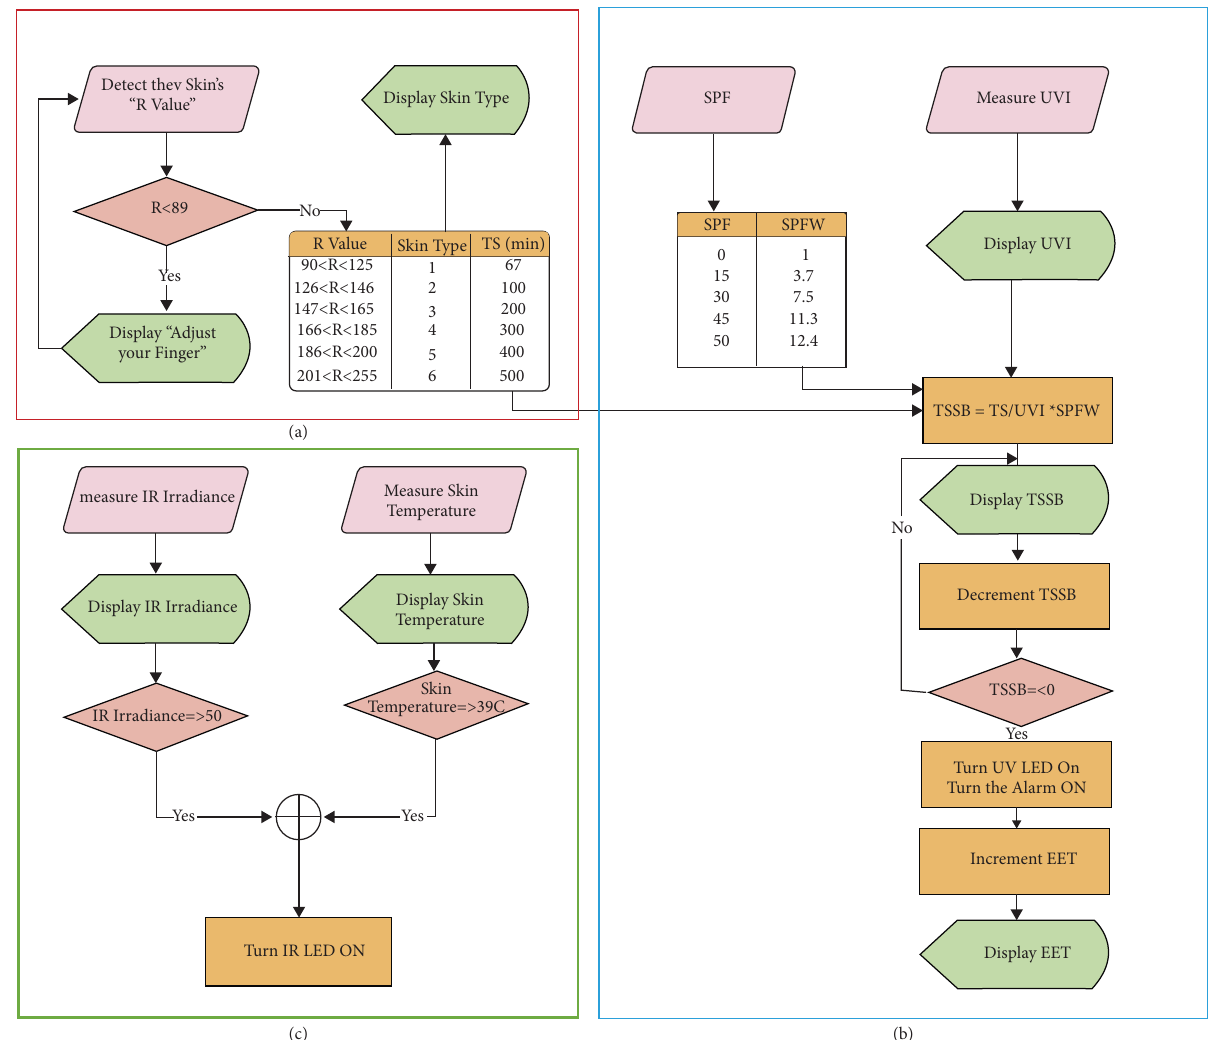
Figure 5: Algorithm behind the solar band. (a) Skin type classifcation algorithm. (b) Exposure time algorithm. (c) IR alarm algorithm. Pink blocks for input data, red for if conditions, orange for processes, and green for displaying. Table 4: Time to sunburn in minutes for six skin types without sunscreen at diferent UVI [22,